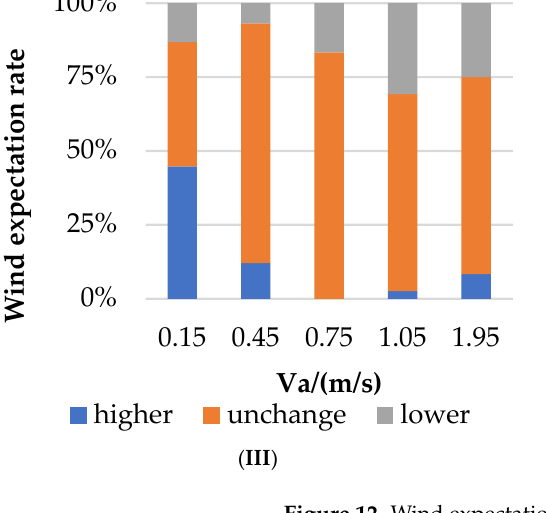
Figure 12. Wind expectations in groups I, II, III, and IV. ( I ) Square in August and October. ( II ) Square in November, December, and January. ( III ) Lake side in August and October. ( IV ) Lake side in November and December.